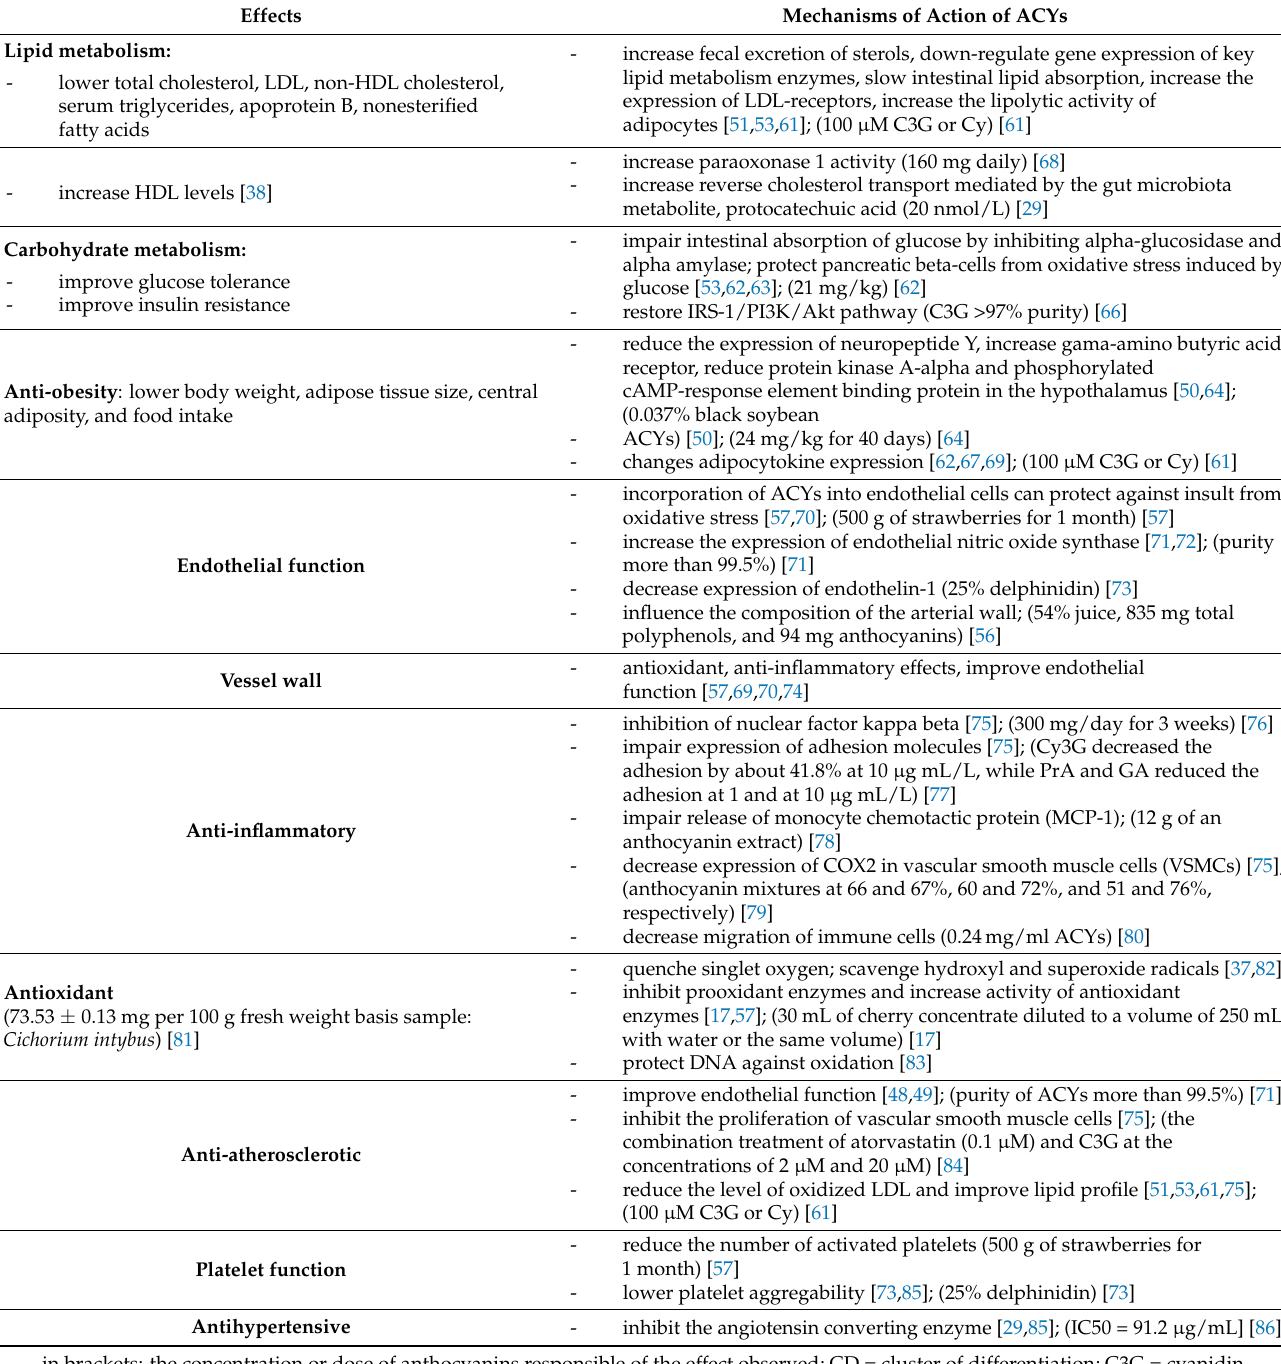
Table 2. Key-mechanisms of cardiovascular benefits of anthocyanins